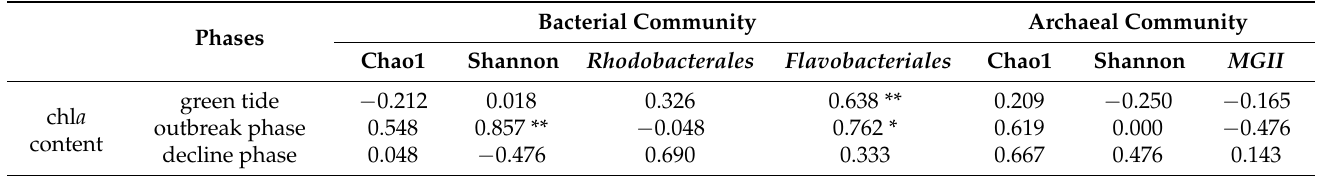
Table 4. Spearman correlation analysis of Chao1 index, Shannon index, relative abundance of dominant taxa with chl a content during the green tide, the outbreak and decline phase.